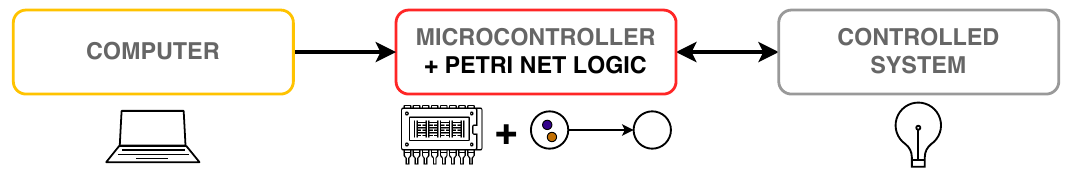
Figure 1. Basic scheme of proposed solution—Petri net’s logic in microcontroller.